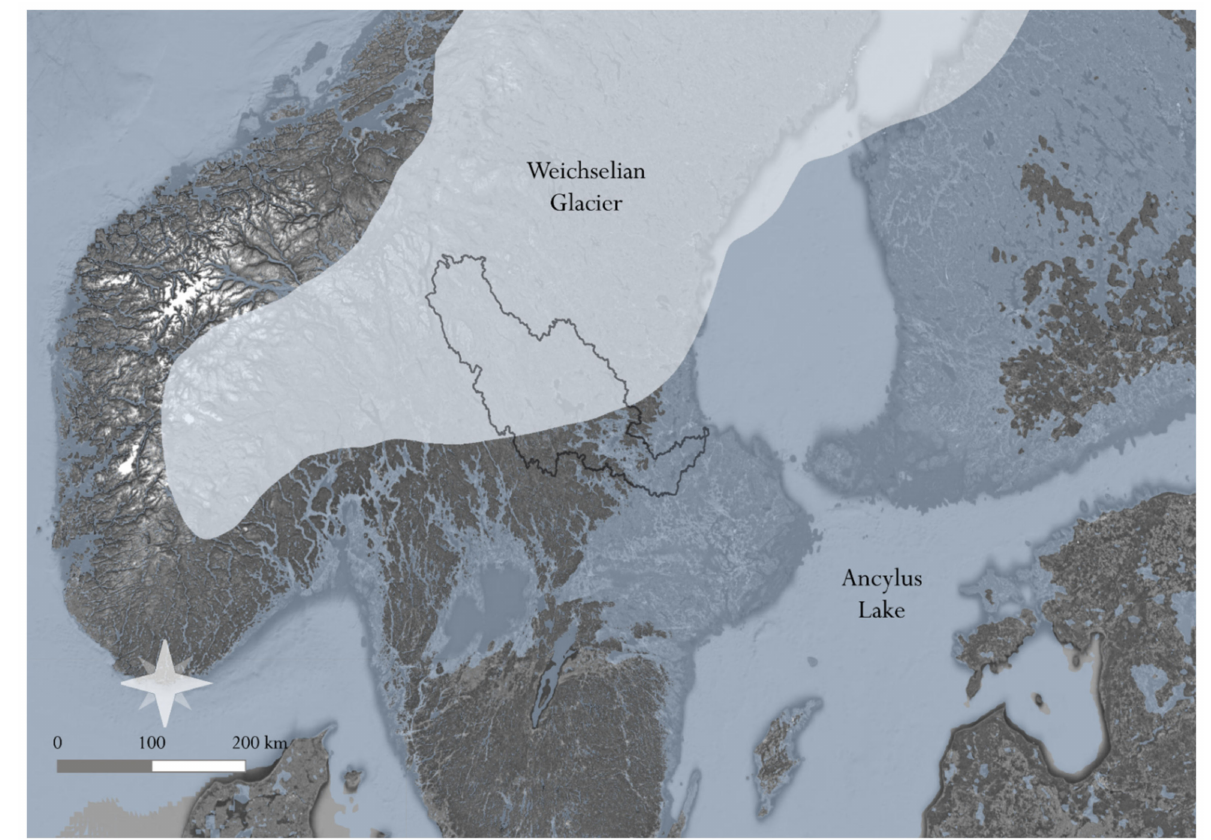
Figure 2. Weichselian ice sheet and shorelines in 8800 BC in relation to the Dalälven catchment study area; shoreline data provided by Strandnivåer Rikstäckande© SGU; boundaries’ shapefiles courtesy of the European Environmental Agency (EEA); background map courtesy of Google